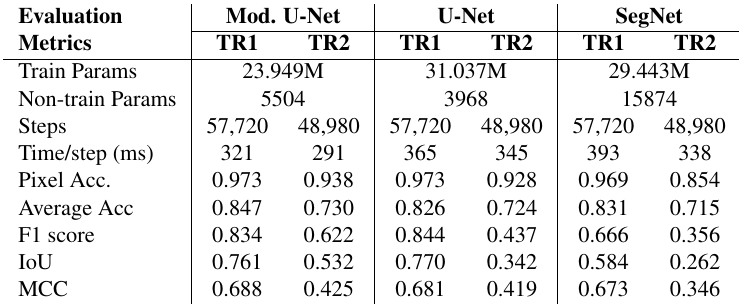
Table 1 . Same-domain validation results of the modified U-Net on TR1 and TR2 datasets compared to U-Net and SegNet. Evaluation